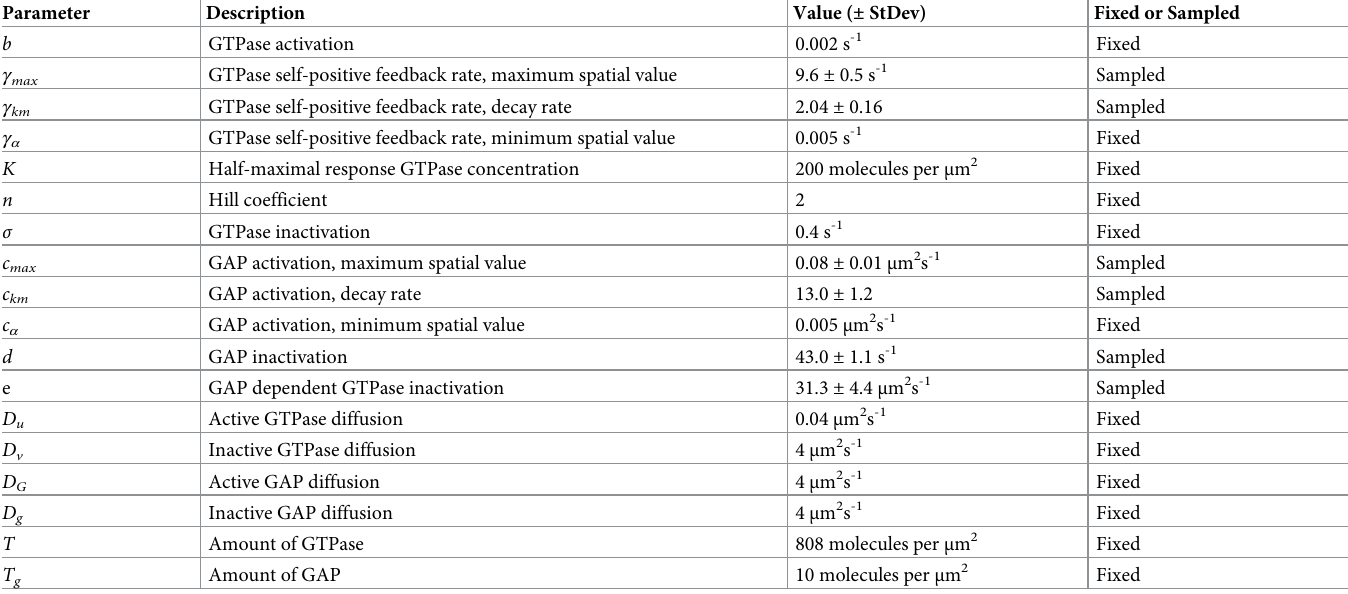
Table 2. Mean parameter set after MCMC parameterization.